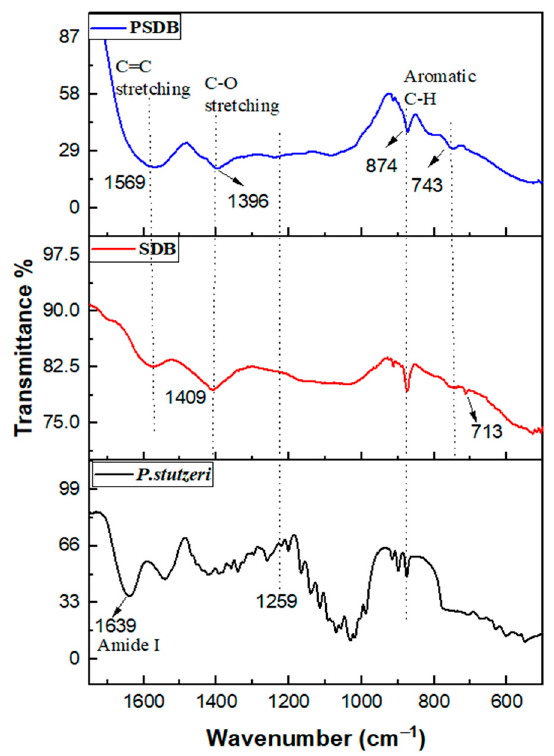
Figure 5. FTIR spectra of Pseudomonas stutzeri, SDB and PSDB.